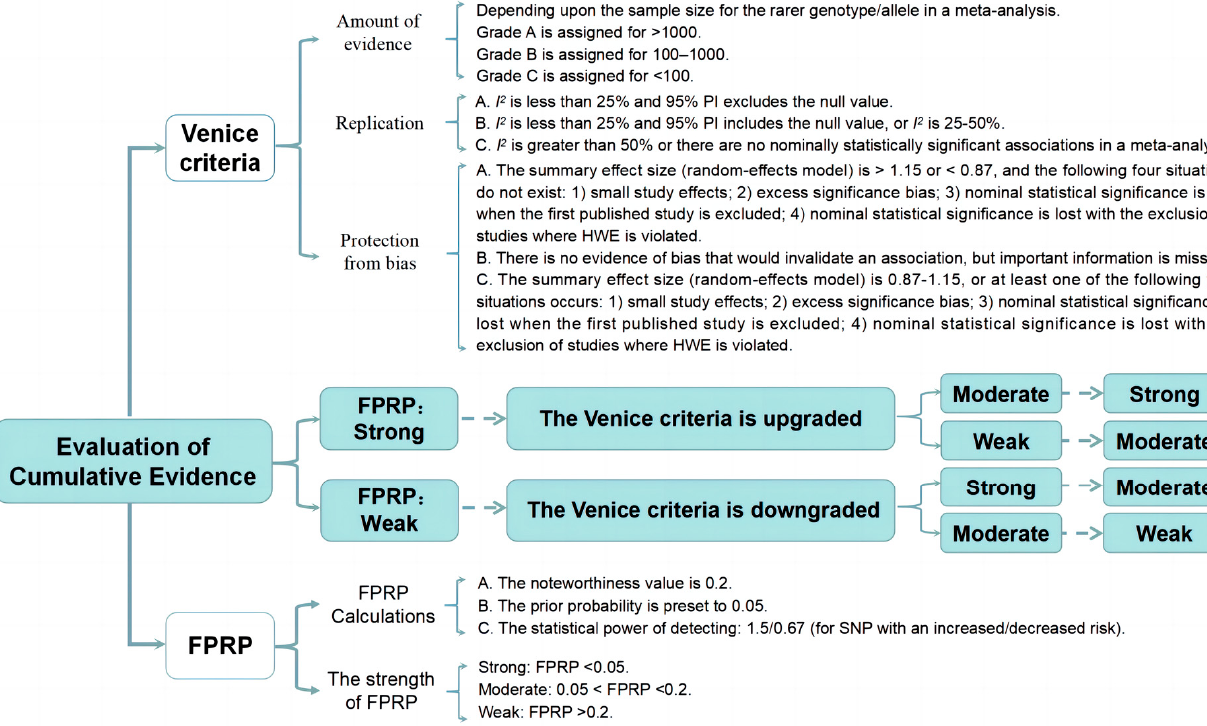
Figure 1. The criterion for evaluating cumulative